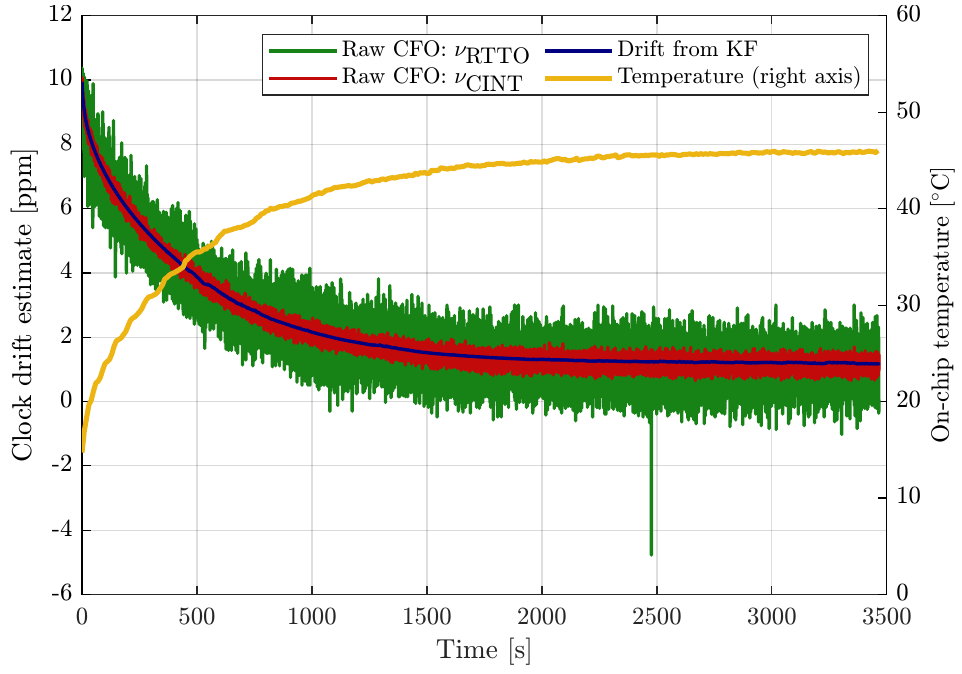
Figure 1. Raw measurements of relative CFO based on RTTO (green) and C int (red), drift estimated by Kalman filter (blue) included for comparison. Moving average of receiver temperature (yellow) corresponds to the right